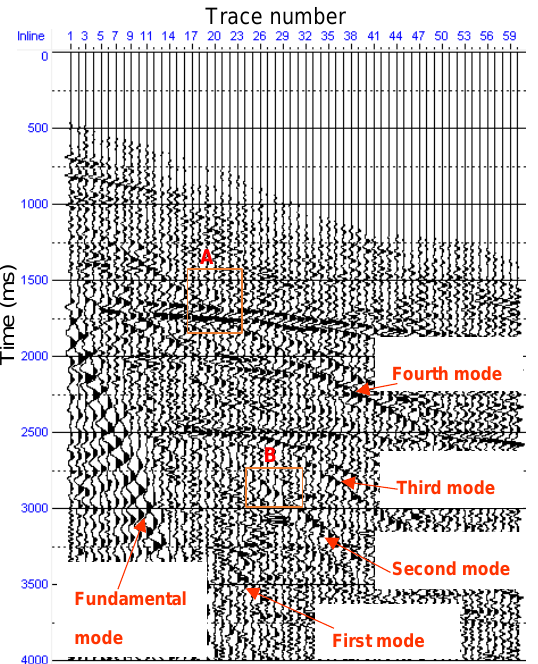
Figure 9. The X-component field data of 2D3C seismic data acquired in the Wangjiatun District, Daqing Oilfield, China.